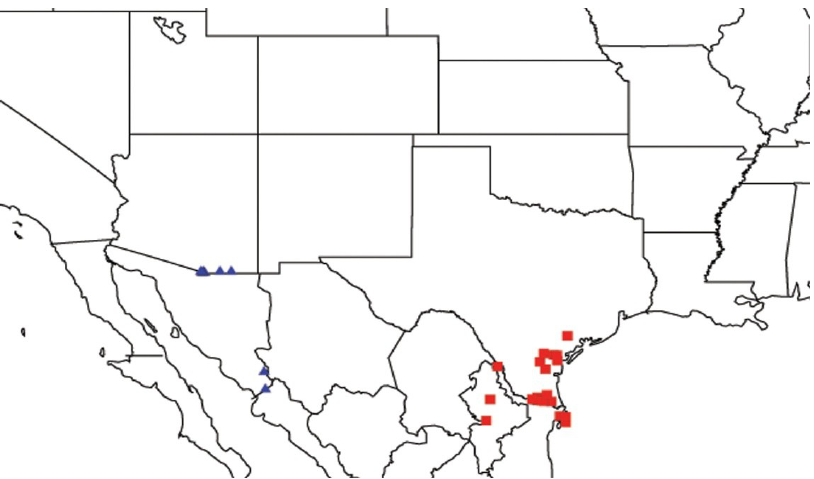
Figure 26. Distribution of Cornuplura nigroalbata (blue triangles) and Quesada gigas (red